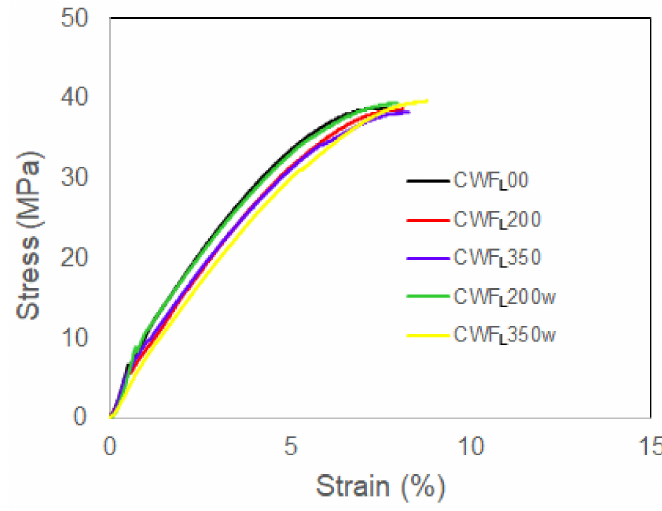
Figure 4. Stress–strain curves of CWF L type composites: CWF L 00, CWF L 200, CWF L 350, CWF L 200w, and CWF L 350w.